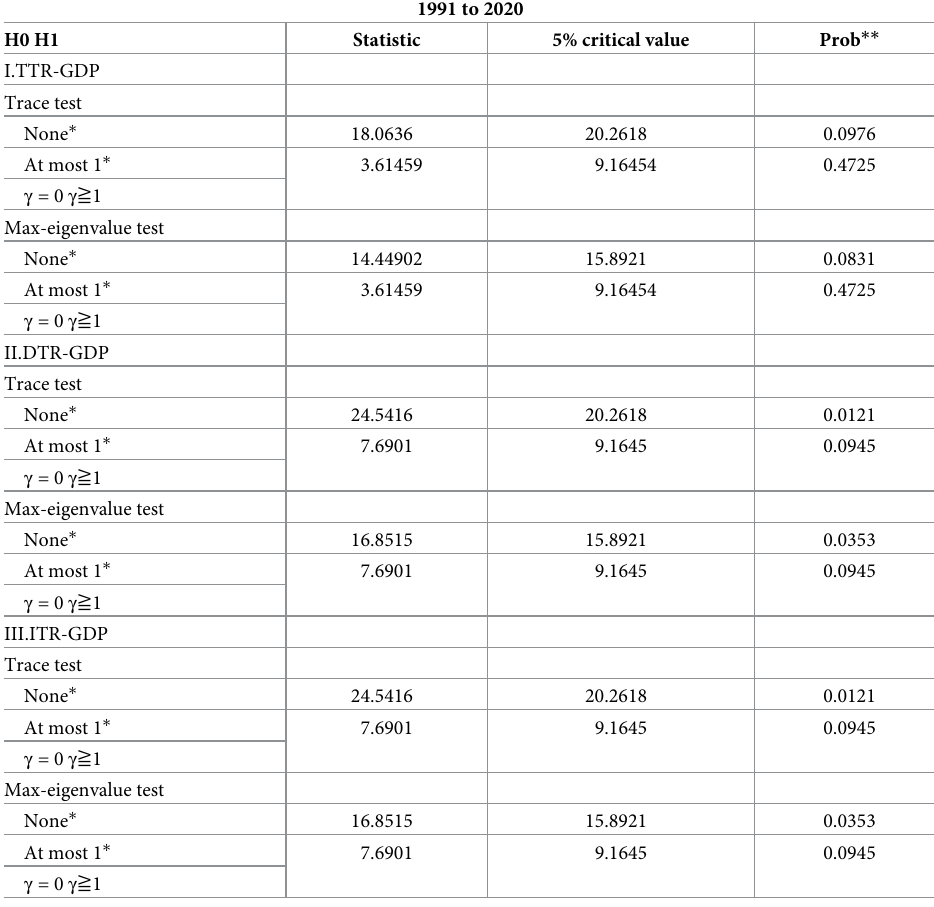
Table 3. Performance of Johansen Cointegration test,